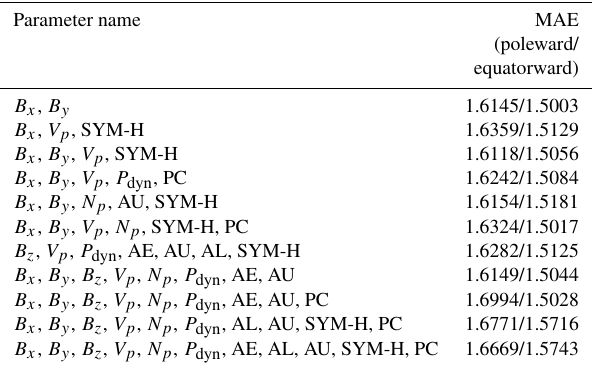
Table 6. The MAE influenced by different combinations of space physical